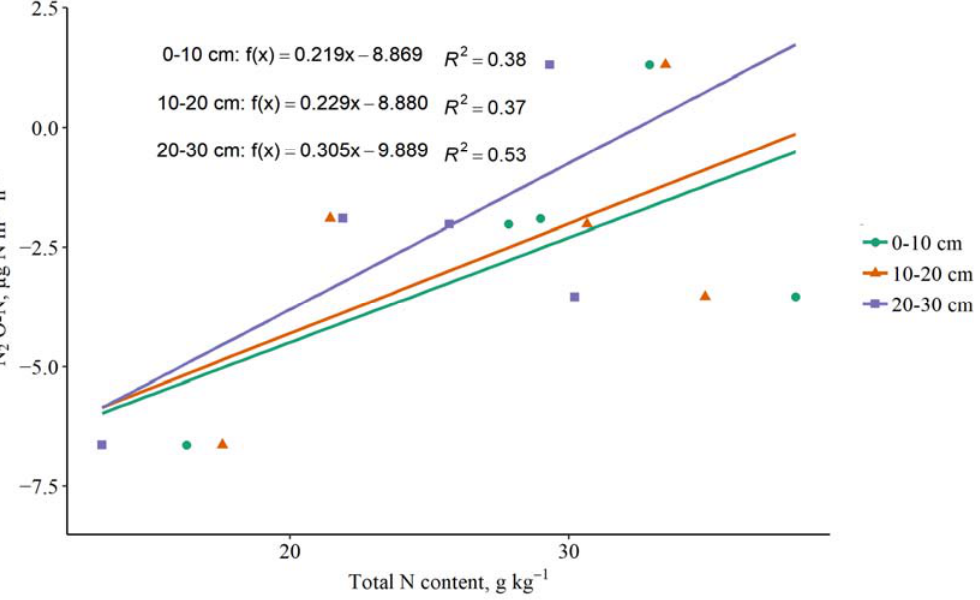
Figure 13. N 2 O fluxes depending on total N content in soil at 0–10 cm, 10–20 cm and 20–30 cm depth in silver birch and black alder stands without outliers.